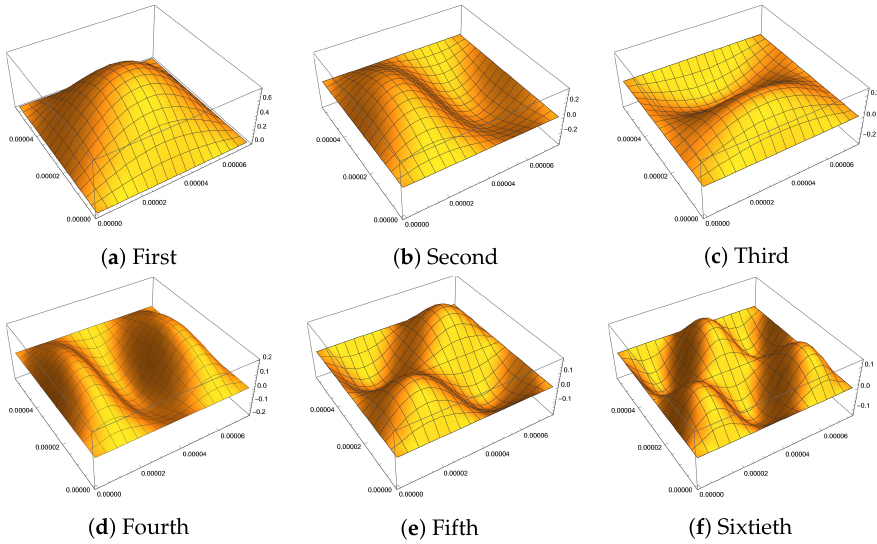
Figure 1. First six eigenfunctions obtained by the FEM with a 6 × 5